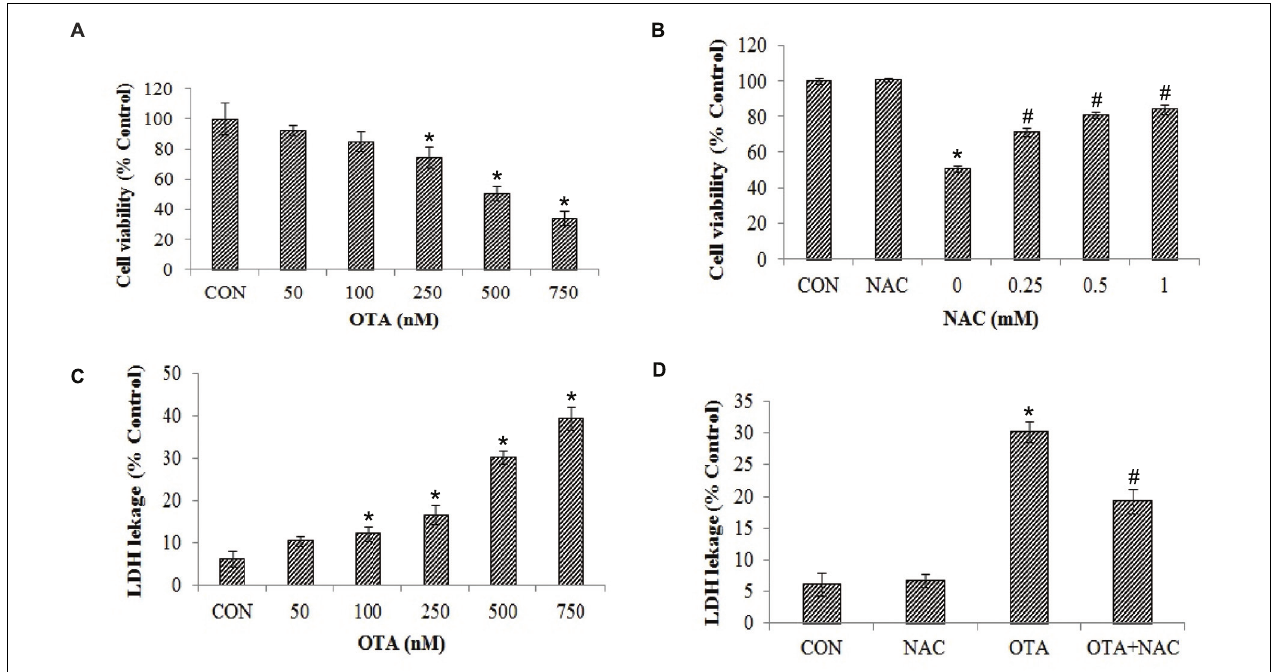
FIGURE 1 | Cytotoxicity of Ochratoxin A (OTA) in Neuro-2a cells and its reversal by N -acetylcysteine (NAC). (A) Neuro-2a cells were treated without or with various concentrations of OTA (50–750 nM) for 24 h. Cells survival was measured by MTT assay. (B) Neuro-2a cells were pretreated without or with NAC (0–1 mM) for 1 h and challenged with different concentrations of OTA for 24 h and viability was accessed by MTT assay. (C) Membrane damage was measured by LDH leakage assay. (D) Neuro-2a cells were pretreated without or with NAC (1 mM) for 1 h and challenged with OTA (500 nM) for 24 h and viability was accessed by LDH leakage assay. The data represented as mean ± SEM of three independent experiments. ∗ p < 0.05 versus respective control group and # p < 0.05 versus respective OTA treated group.